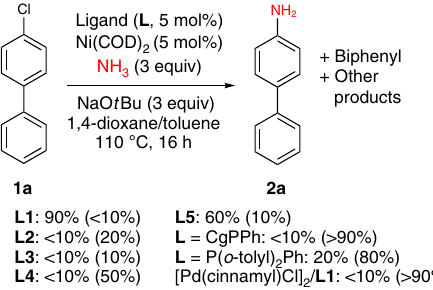
Figure 3 | Preliminary ligand screen in the nickel-catalysed monoarylation of ammonia. Reactions employed 4-chlorobiphenyl (0.12mmol), 0.5M stock solutions of ammonia in 1,4-dioxane (0.72ml) and toluene (1.00ml). Conversions estimated on the basis of gas chromatographic data, reported as % 4-aminobiphenyl (% 4-chlorobiphenyl unreacted); mass balance attributable to biphenyl and/or other unidentified products; COD, 1,5-cyclooctadiene.